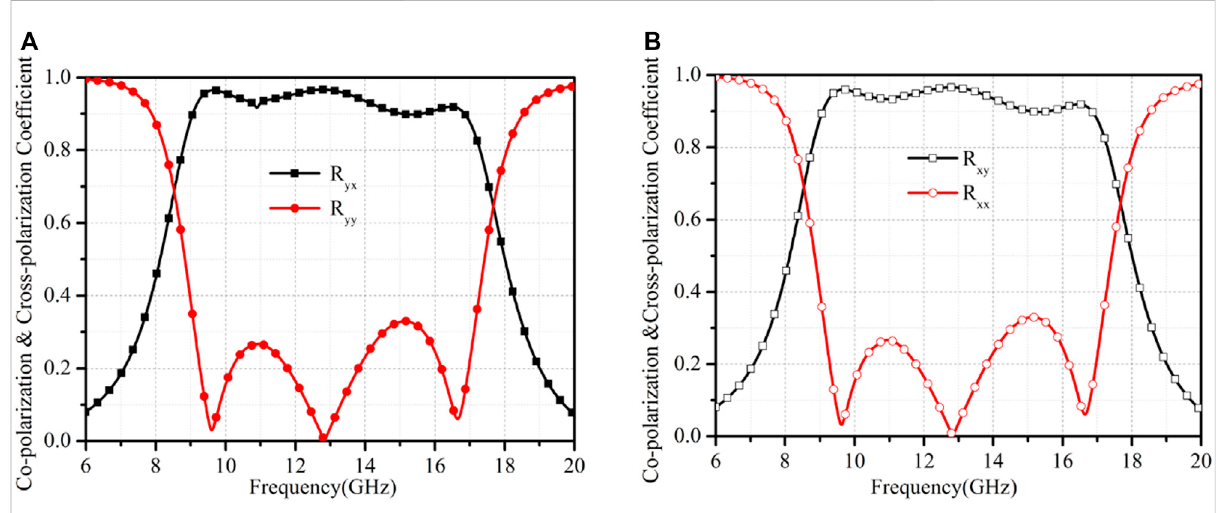
FIGURE 2 Simulated results of the co-polarization and cross-polarization re fl ections for (A) TE-polarized wave and (B) TM-polarized wave.